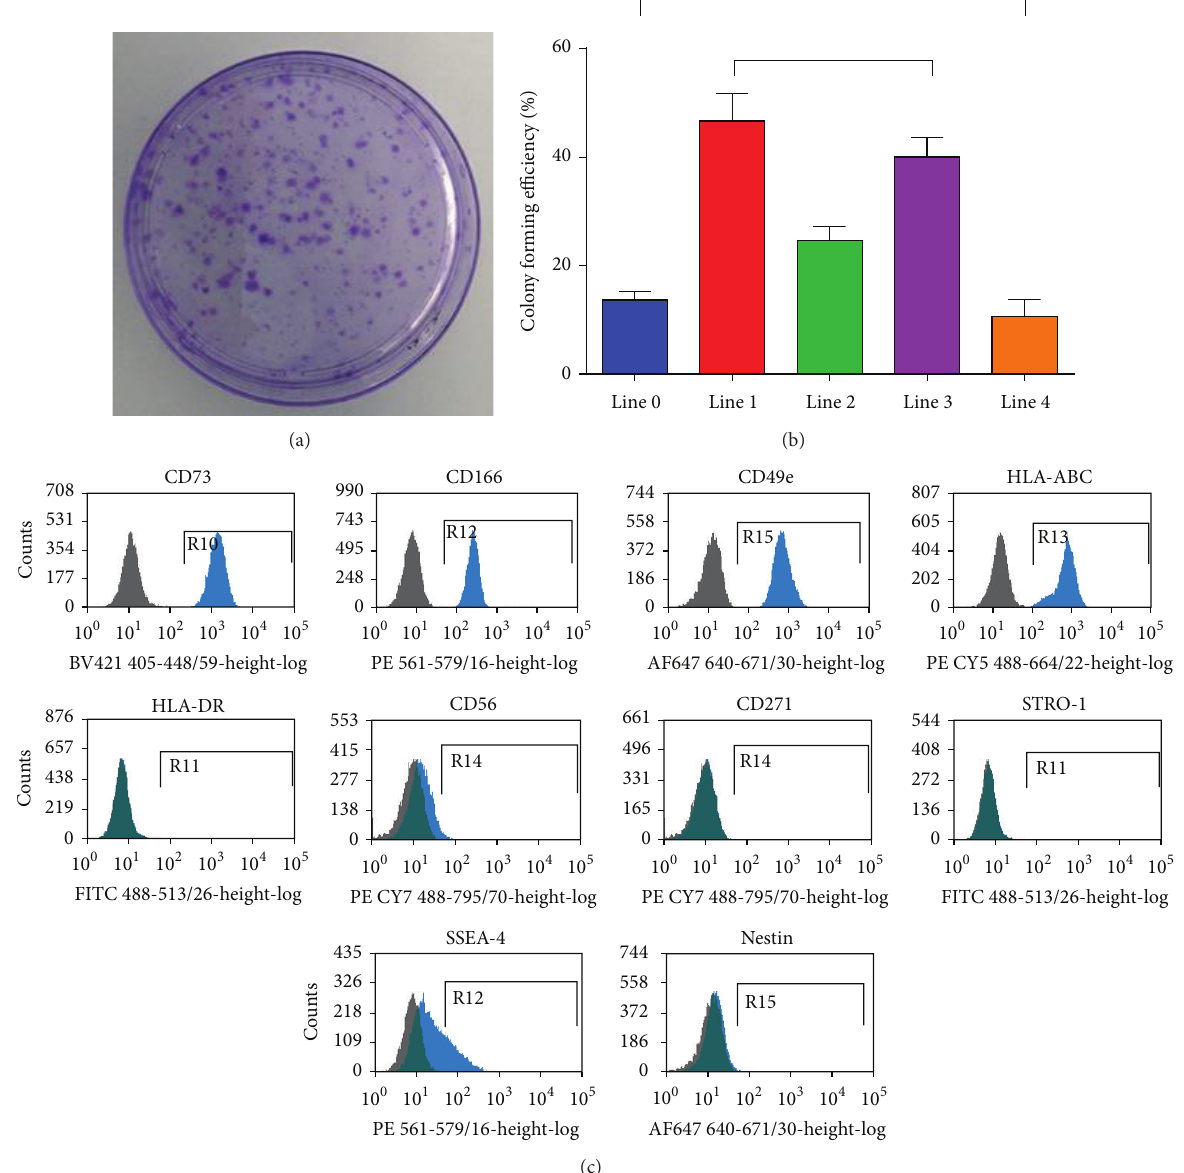
Figure 2: Characteristics of human neonatal sbMSCs. (a and b) Neonatal sbMSCs were clonogenic as demonstrated by colony forming efficiency. (b) Colony forming efficiency was significantly different between the sbMSC lines by one-way ANOVA followed by post hoc Tukey test,exceptforthebracketedcombinations.(c)NeonatalsbMSCssurfacemarkercharacterizationbyflowcytometry.Resultsarerepresentative of 3 other